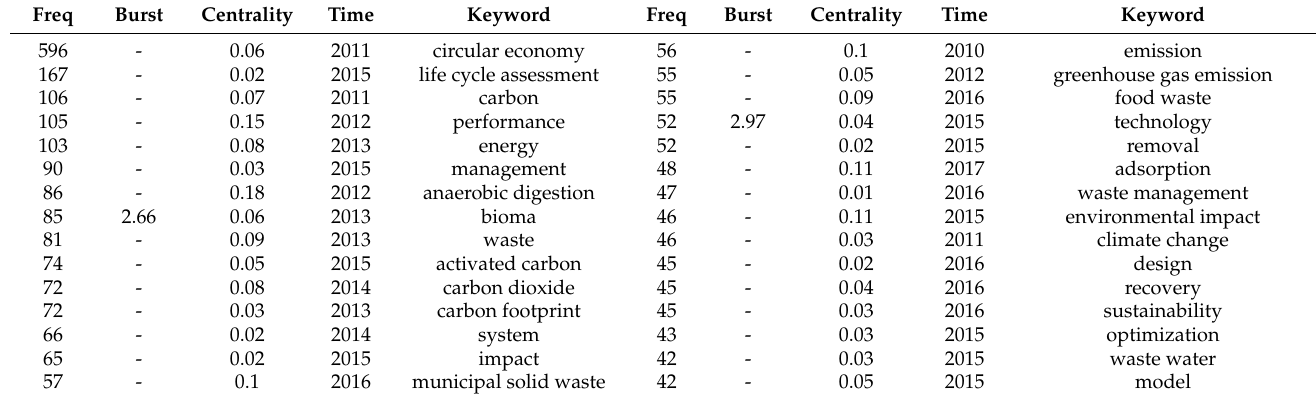
Table 7. Ranking of top 30 active keywords based on frequency